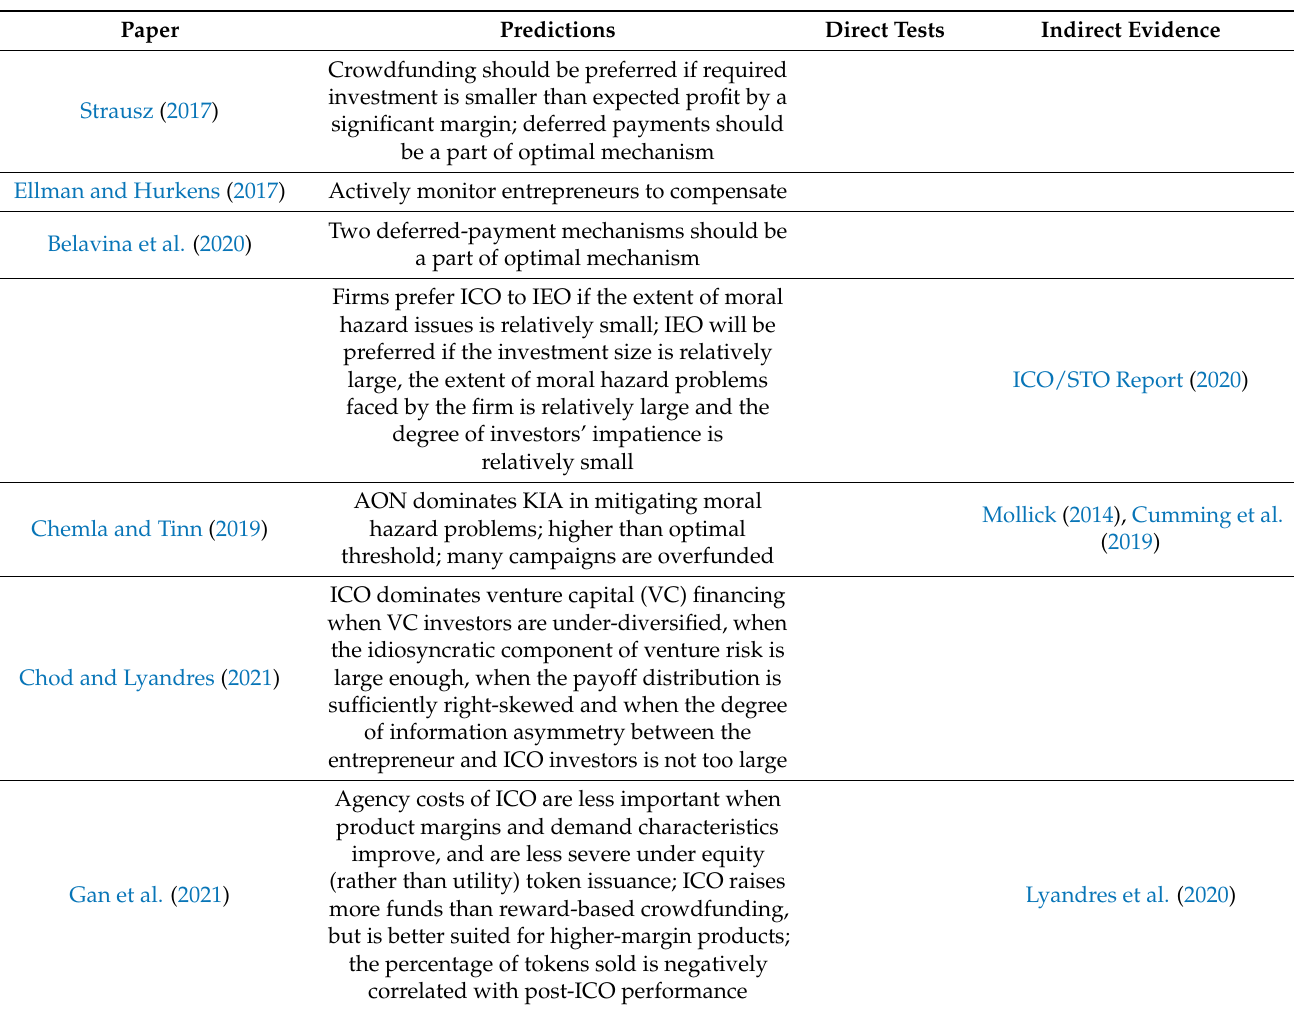
Table 7. Moral hazard-based theories (part 2) of crowdfunding and token